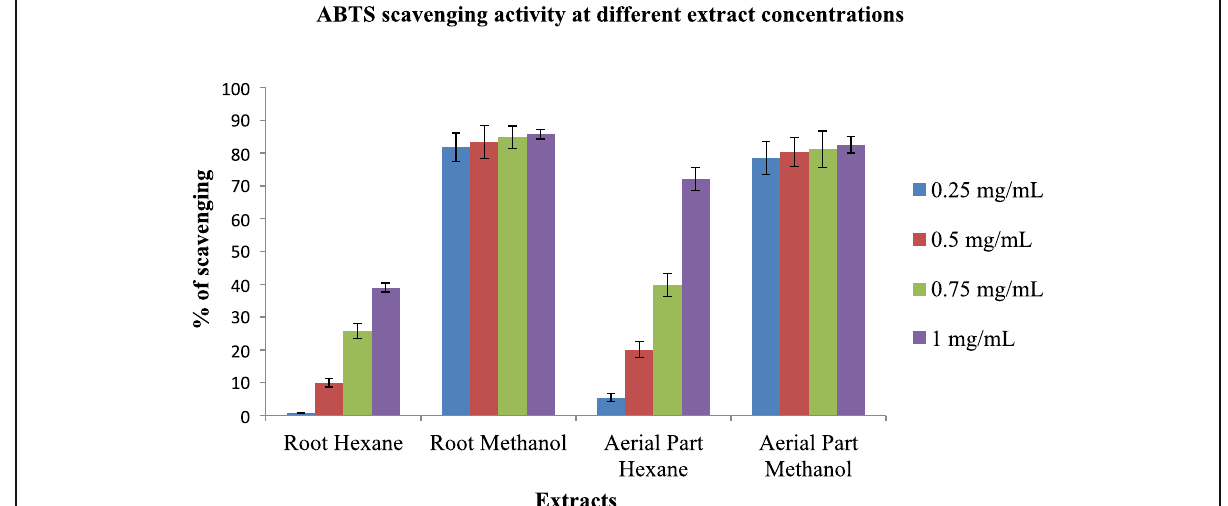
Fig. 2 ABTS scavenging activity of different extracts of V . coriaceum at different concentrations